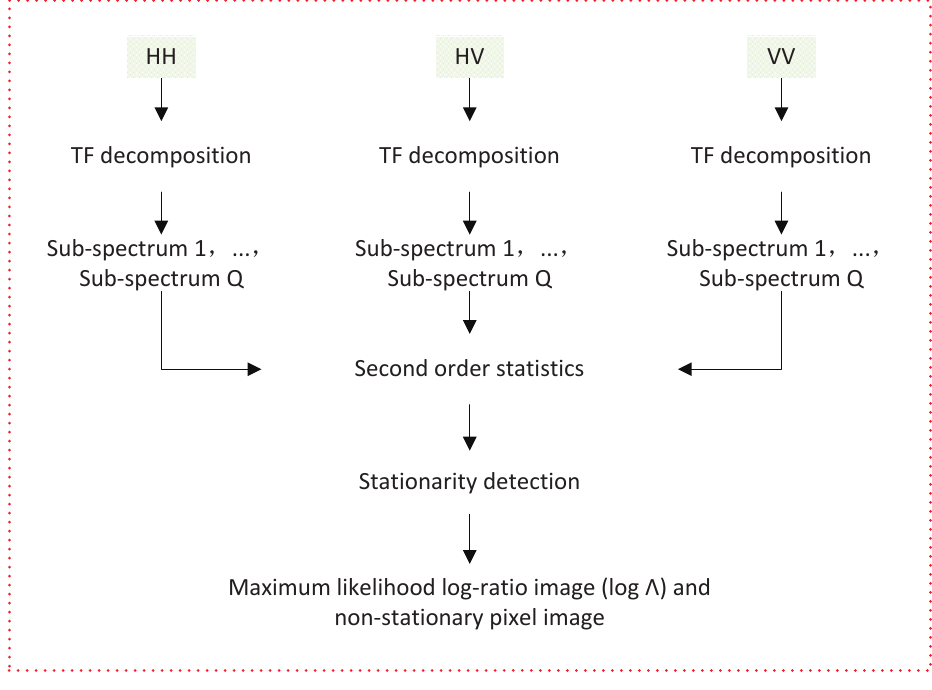
Figure 4. The process of 2D TF